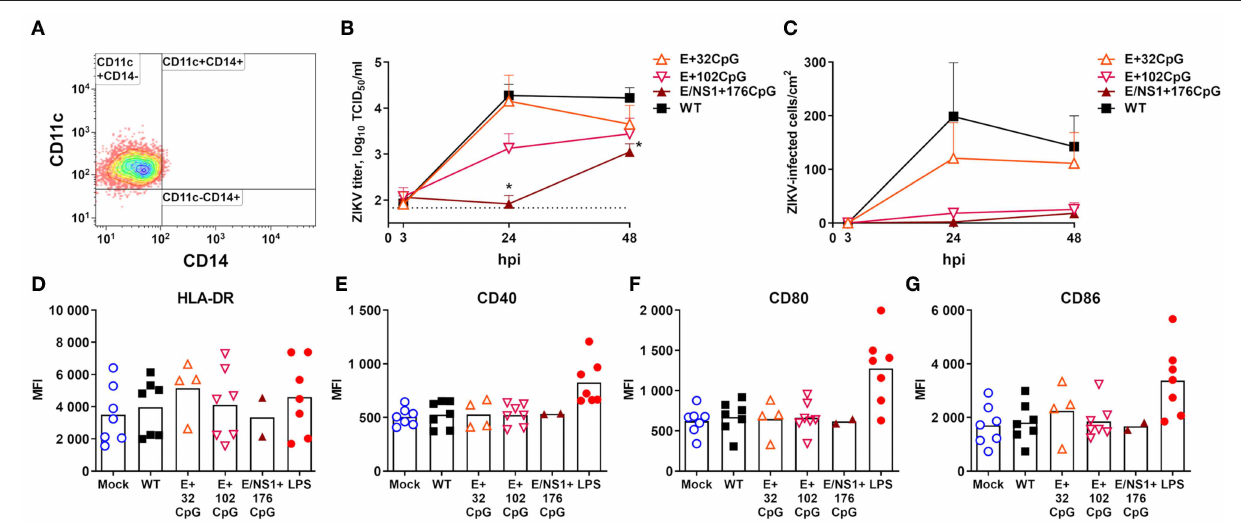
FIGURE 5 | Virus infection kinetics in human moDCs after inoculation at MOI of 1. (A) MoDCs were generated from blood cells of eight adult females sampled at birth or shortly before birth and one adult male. Differentiation of CD14 + monocytes from human blood resulted in a typical moDC phenotype. In this experiment, we excluded the permuted ZIKV variant because the number of moDCs was limited. (B) An asterisk (*) denotes a statistically significant difference between WT and E/NS1 + 176CpG ZIKV variants. The dotted horizontal line represents the limit of detection. (C) The 96-well plates with moDC cells were stained with ZIKV-specific Abs and ZIKV-infected cells were counted in the well with bright-field microscopy at 200x ( Figure 4 ). Whiskers represent SE from nine donors with two technical replicates. (D–G) Expression of flow cytometry markers in moDCs inoculated with ZIKV variants (MOI = 1) and measured at 48h post inoculation. Bars represent mean values. LPS (100ng/ml Lipopolysaccharide; Sigma L5418) was used as a positive control. MFI, mean fluorescent intensity; hpi, hours post inoculation.